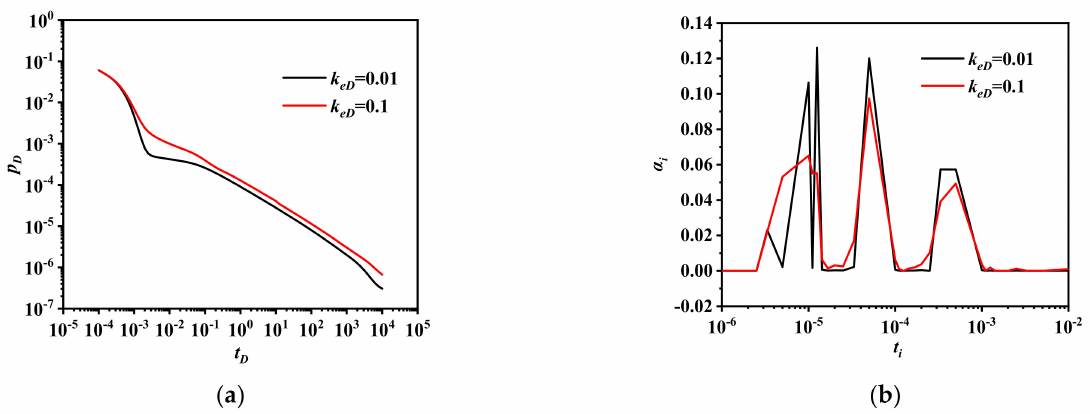
Figure 5. Effect of diffusion coefficient, porosity and permeability of the unstimulated region on well rate. ( a ) Dimensionless well rate. ( b ) Time scale